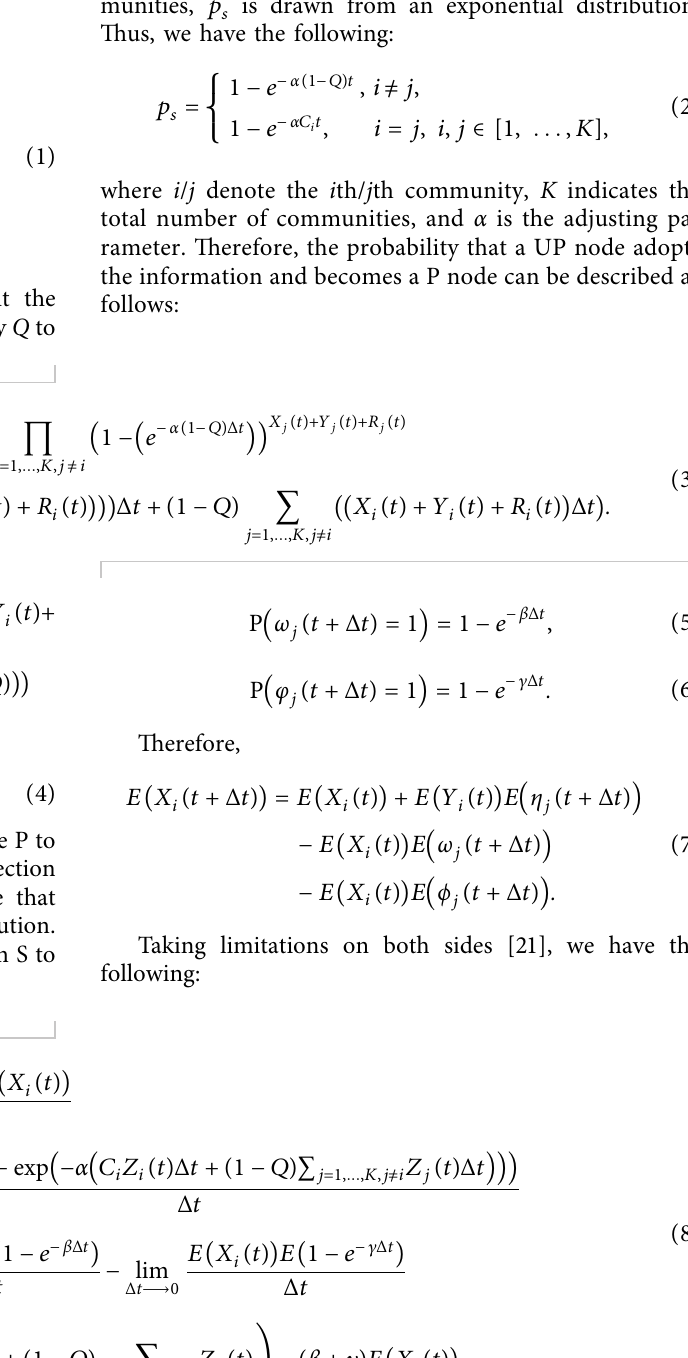
Figure 1: The diffusion process of an Internet investment